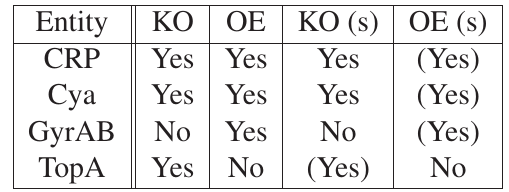
Figure 8: Results of entity knock out (KO) and overexpression (OE) in the Boolean model. (i.e. state 1 ) in the Boolean mutants which contradicts the results for the multi-valued model. This appears to be due to the Boolean model being less restrictive with respect to the activation of